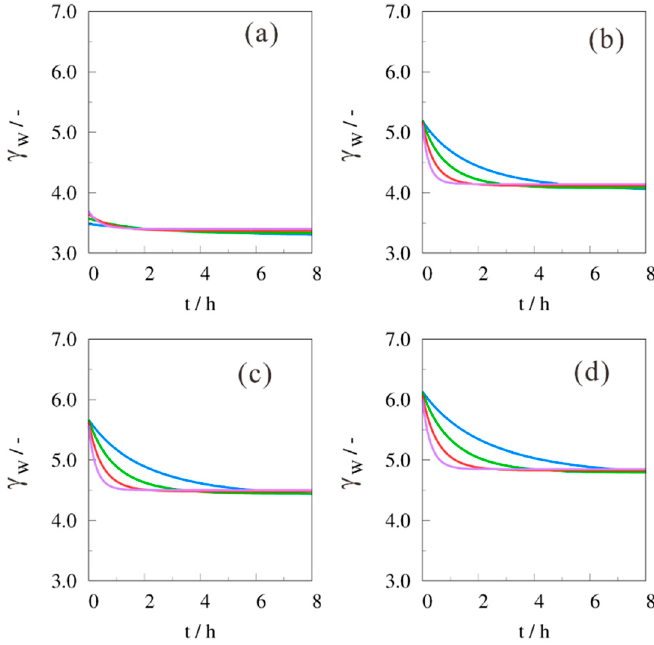
Figure 6. Activity coe ffi cient for W versus reaction time with ( B / H ) 0 = 2 mol · mol − 1 . Solvent = ( a ) methanol; ( b ) ethanol; ( c ) n-propanol; ( d ) n-butanol; T = ( ─ ) 80 °C, ( ─ ) 100 °C, ( ─ ) 120 °C, ( ─ ) 140 °C.